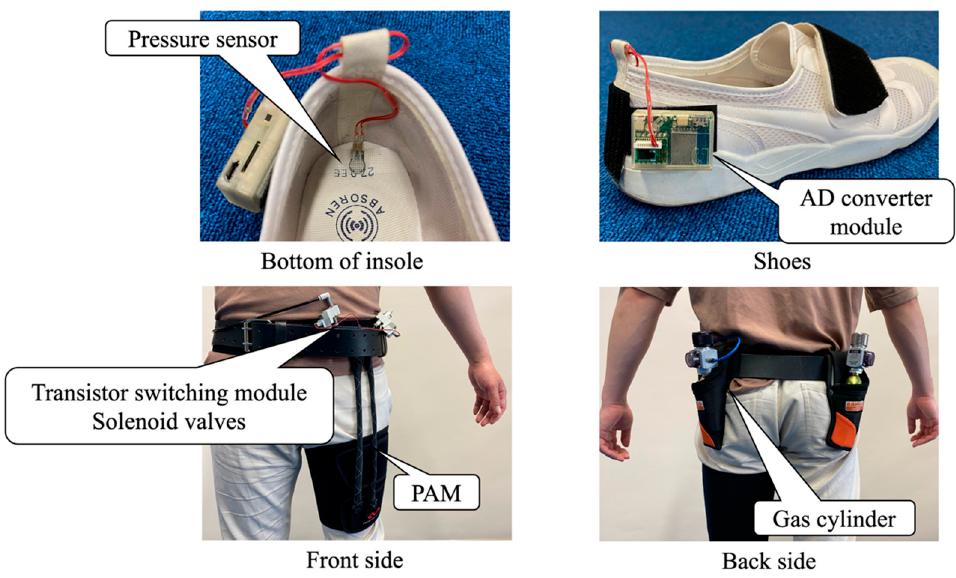
Figure 2. Setup of PAM driver system for supporting hip flexion motion. A pressure sensor is inserted under the right heel to detect the heel contact with the ground. Two McKibben-type pneumatic artificial muscles (PAMs) are attached to support hip flexion motion. An AD converter module is affixed to the shoes and a transistor switching module and gas cylinder are fixed to the waist belt.